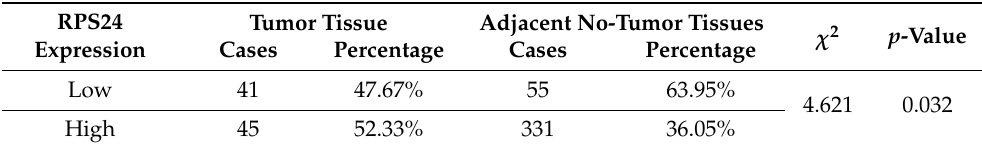
Table 2. Immunohistochemical analysis showed the expression pattern of RPS24 in HCC tissues and adjacent non-tumor tissues.